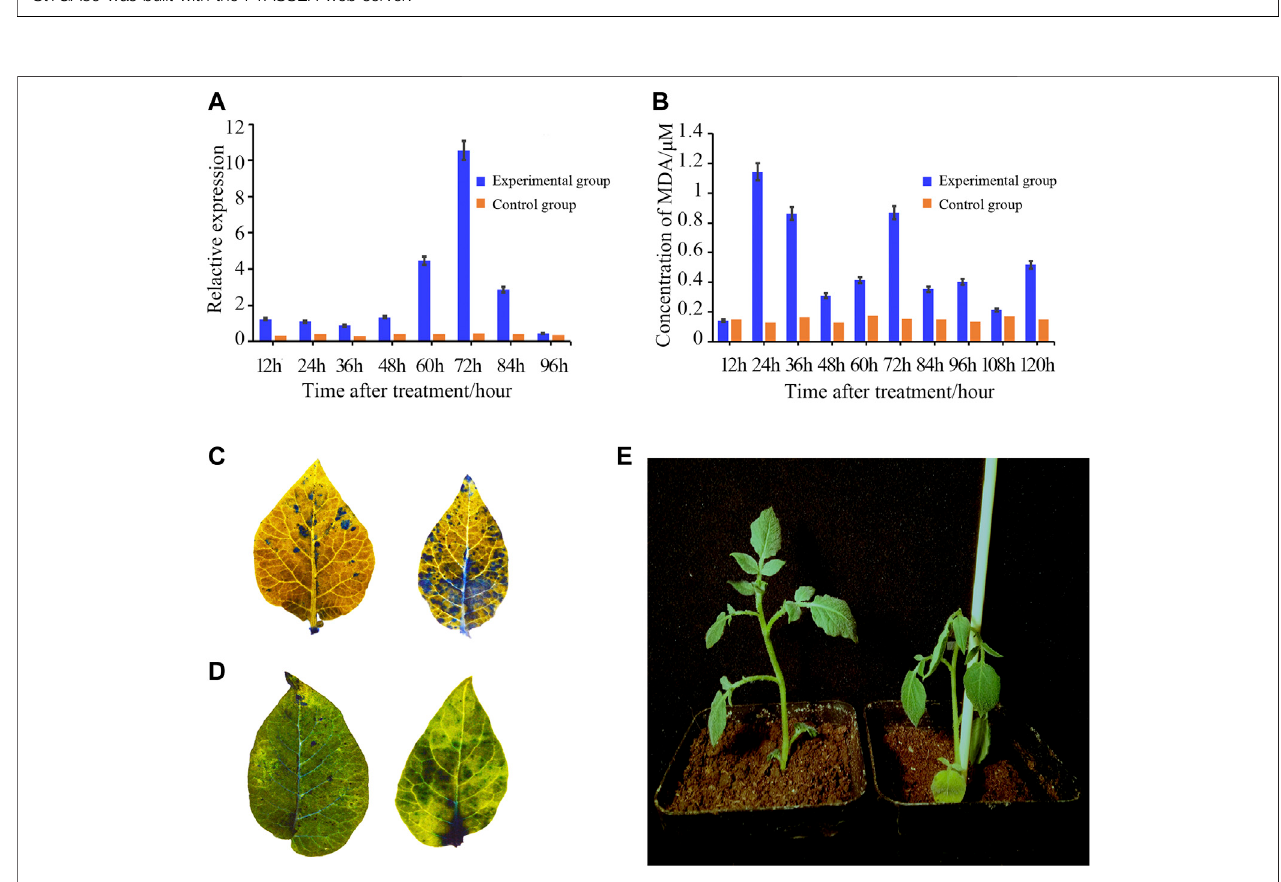
FIGURE 8 | Upregulated expression pattern of StTGA39 and concentration of MDA during R. solanacearum infection on potato. (A) Expression pattern of StTGA39 was induced by R. solanacearum. (B) Levels of MDA in potato plants were assessed at 12, 24, 36, 48, 60, 72, 84, 96, 108, and 120 hpi inoculated with R. solanacearum. (C) Phenotype of two-week-old potato leaves after 72 hpi with fl g22 treatment was compared with WT. (D) Cell death in potato was detected by histochemical staining with trypan blue staining. (E) Photograph showed the phenotype of the WT and was taken 3 days after R. solanacearum infection. mRNA levels were normalized to actin (Student ’ s t-test, n = 3 independent experiments, data shown are mean ± standard deviation).